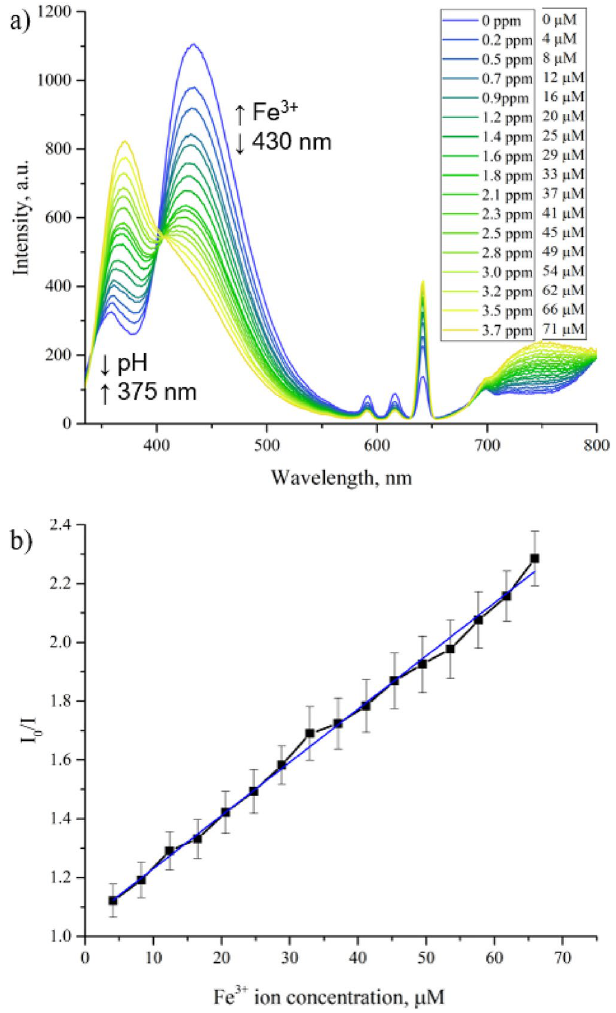
Figure 5. Fluorescence emission spectra (λ exc = 320 nm) of EuBDC-OMe with different Fe 3+ ion concentrations in ultrapure water: (.) concentration in ppm and molarity. Fe 3+ causes fluorescence quenching of the band 425 nm, while band 375 nm increases as a result of pH changes; ( b ) Stern–Volmer plot of EuBDC-OMe band 430 nm quenched by Fe 3+ ions. Error bars represent ± standard deviation (n =